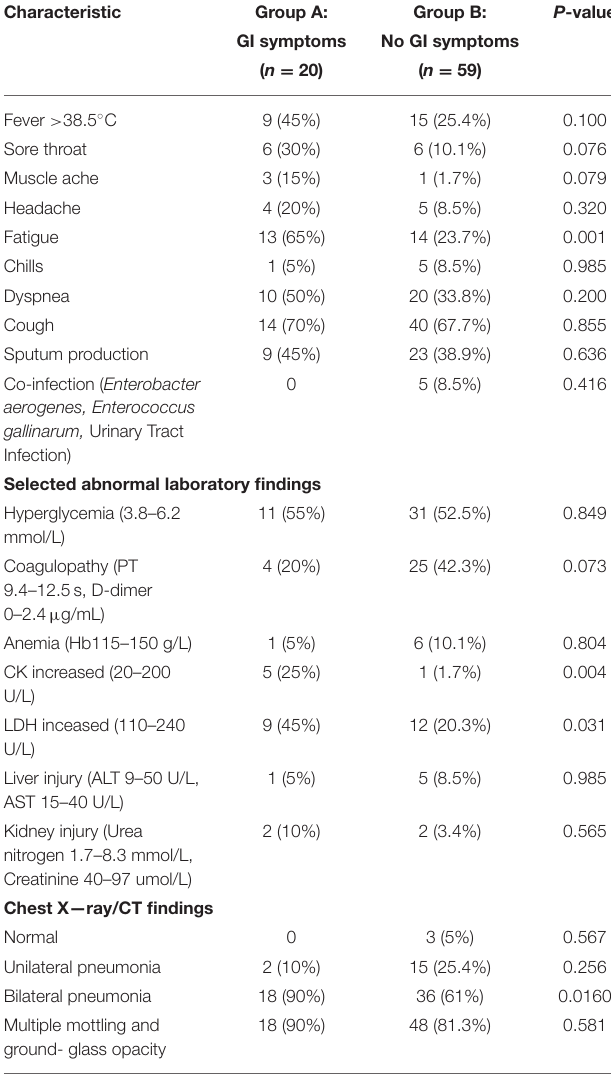
muscle ache. The percentage of patients with higher CK (25 vs. 1.7%; p = 0.004) and LDH (45 vs. 20.3%; p = 0.031)